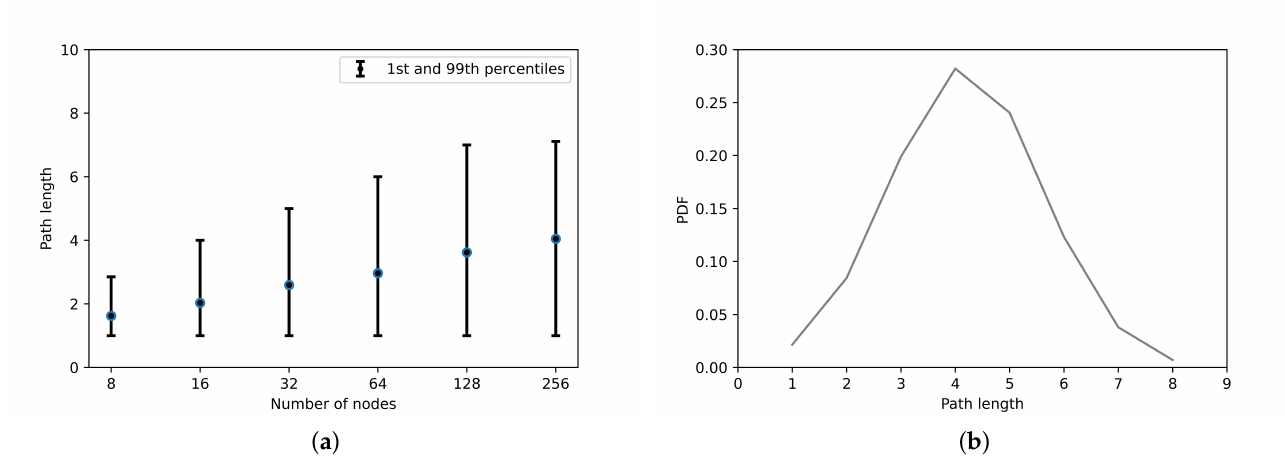
Figure 10. ( a ) The path length as a function of network size. ( b ) The PDF of the path length in the case of a 2 8 node network.